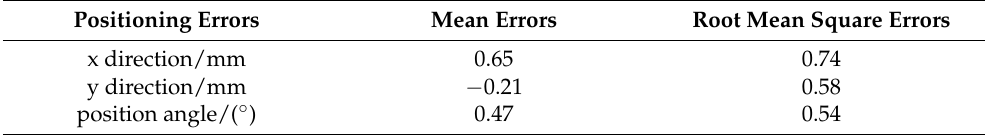
Table 1. Mean and root mean square errors in the positioning of occluded parts.